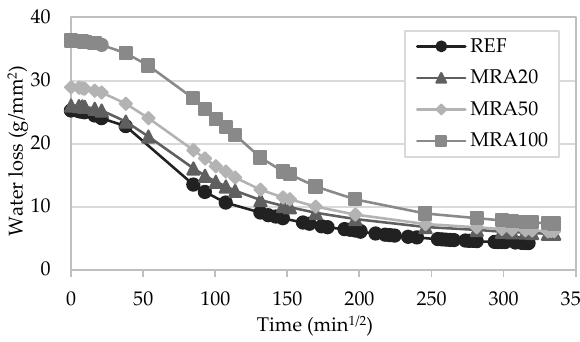
Figure 11. Drying curves of the MRA mortars.